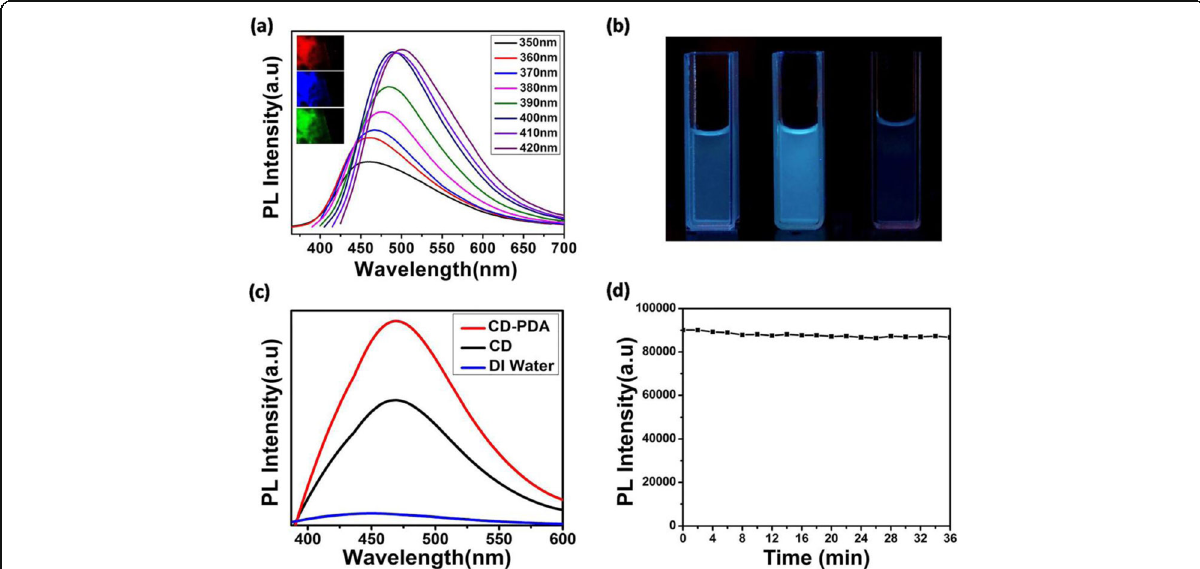
Fig. 2 Optical properties of CD-PDA and CDs. a Photoluminescence spectra of CD-PDA (excitation wavelengths range from 350 to 420 nm with 10 increments, inset: fluorescent microscopy images of CD-PDA). b From left to right: CDs, CD-PDA, and DI water under the UV light irradiation (365 nm). c Photoluminescence spectra of CD-PDA, CDs, and DI water. d Stability curve of the fluorescent intensity of